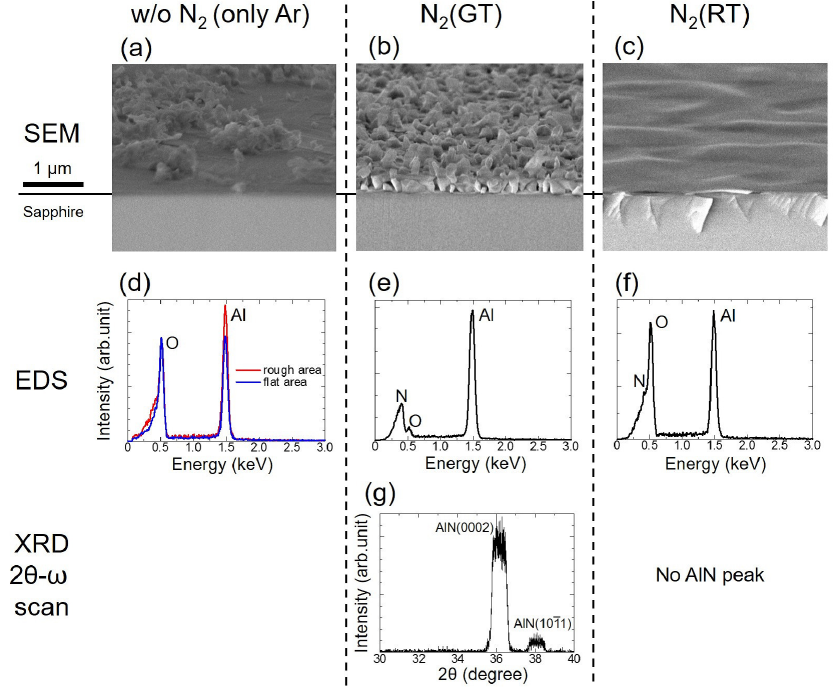
Figure 4. SEM bird’s-eye views of sapphire surfaces after annealing without Al sources in atmospheres ( a ) without N 2 (only Ar); ( b ) with Process N 2 (GT); and ( c ) with Process N 2 (RT). Respective energy dispersive X-ray spectroscopy (EDS) profiles are displayed in ( d – f ); ( g ) XRD 2 θ - ω scan profile for sapphire annealed with Process N 2 (GT) in ( b ).